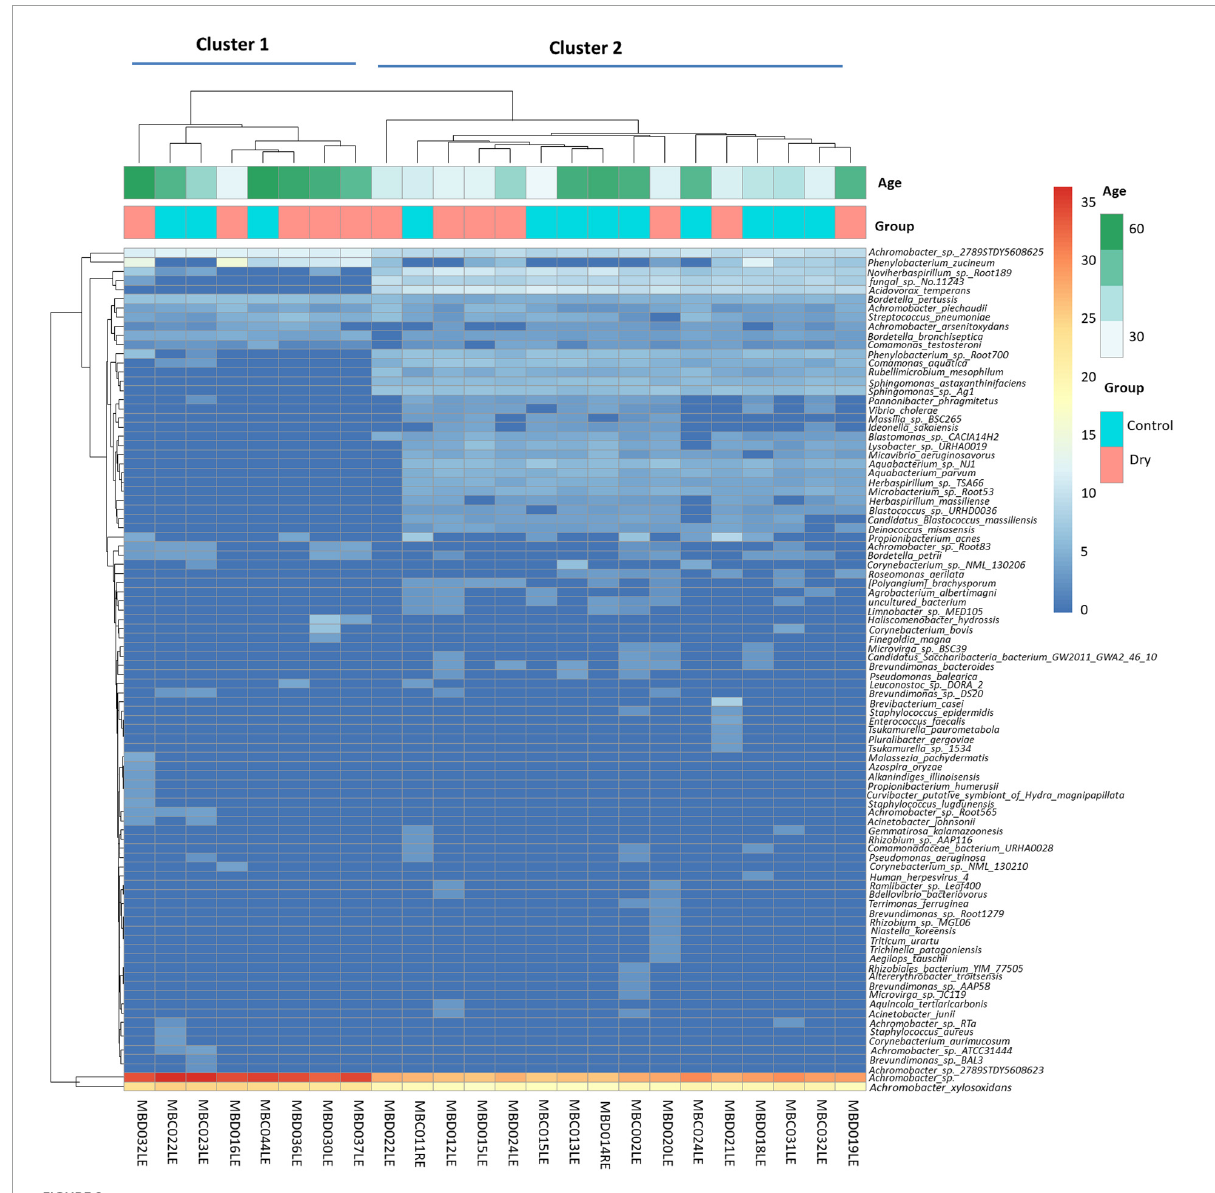
FIGURE2 Heat maps showing hierarchical clustering of abundance of microbial species in the human conjunctival microbiome. This shows two distinct clusters (cluster 1: eight patients, and cluster 2: 16 patients). The identity of the species is indicated on the vertical axis and each column represents one participant. Horizontal axis annotation (top) shows the age of the participants and the dry eye